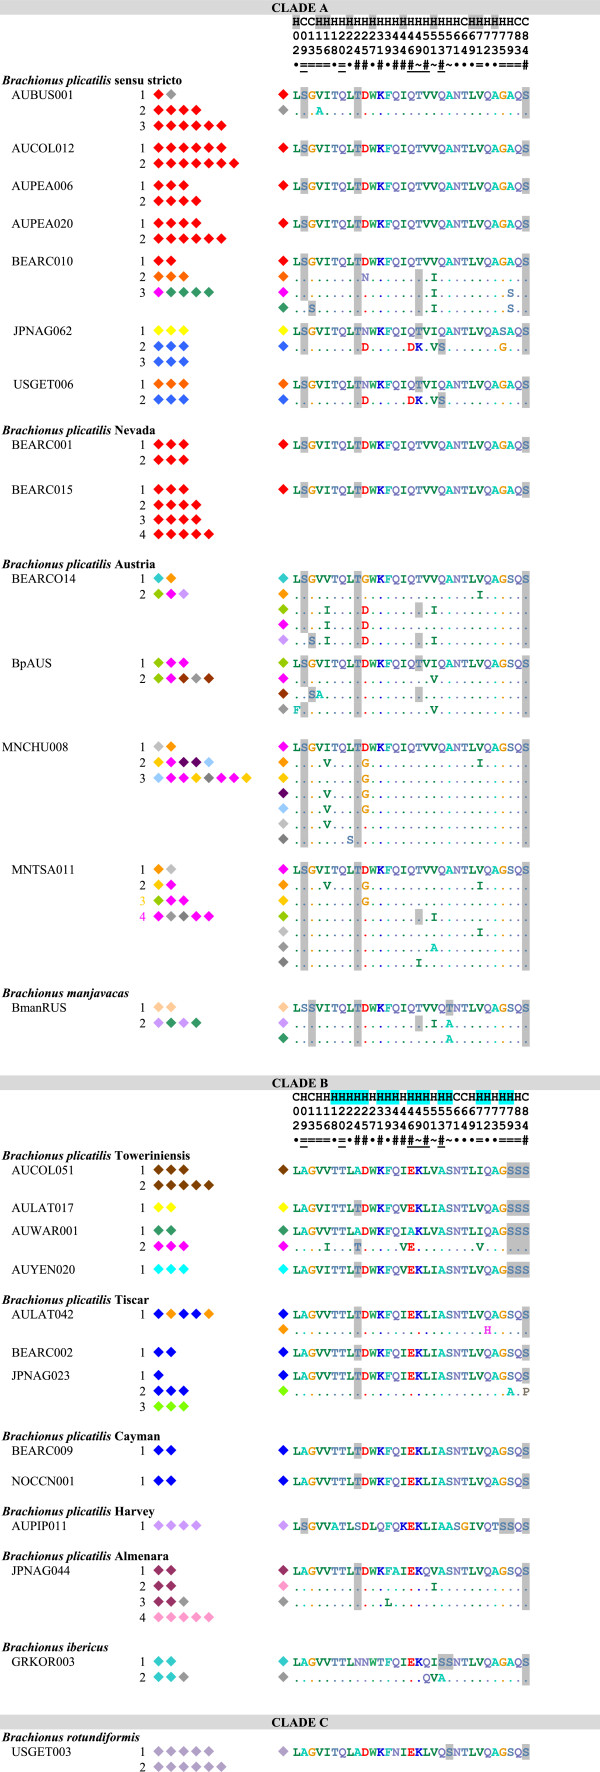
Amino acid identity among full repeat motifs of MMR-B. All gene copies are listed for each species. Each diamond represents one repeat unit in the gene copy; colors indicate identity of repeats. Grey represents repeats with unique amino acid sequences, all other colors represent repeats found multiple times within Clade A or Clade B. Numbered polymorphic positions are shown to the right, with differences from the first repeat of the shortest gene copy shown for each isolate; predicted phosphorylated amino acids are shaded. The consensus prediction of the position being part of a coil (C) or helix (H) is shown above the position numbers, with positions predicted to be buried in the hydrophobic core shaded. Symbols below the position numbers indicate if the polymorphism is unique to a single repeat (·), alternates between only two (=) or almost always two (~) residues, or is more polymorphic (#). Underlining indicates synapomorphies between Clades A and B.